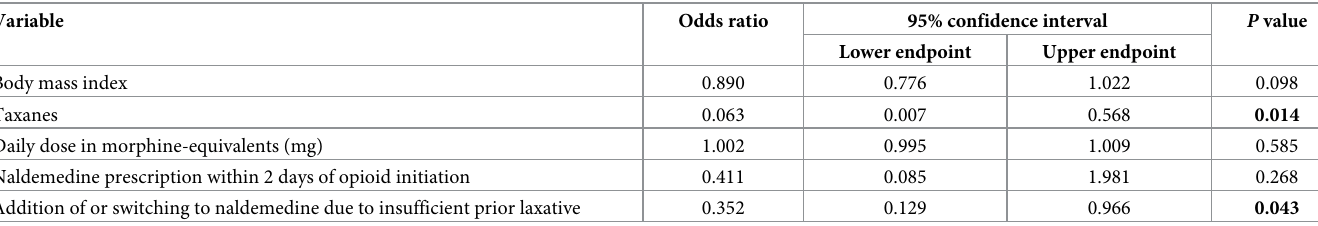
Table 3. Relative odds of naldemedine effectiveness in a multivariate model (n = 106).